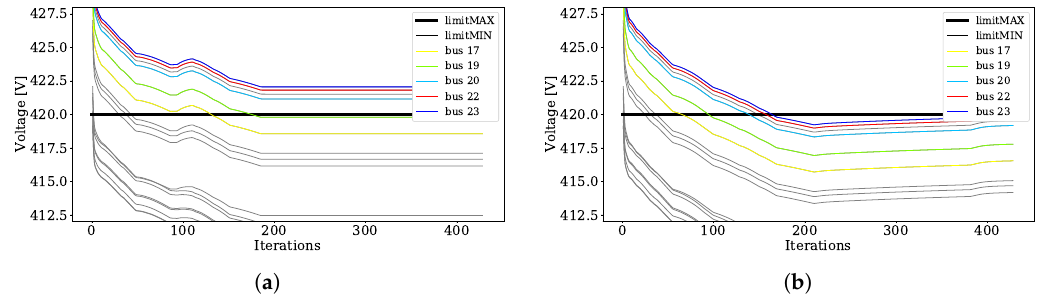
Figure 13. Voltage profile without virtual nodes and with virtual nodes. ( a ) Without virtual nodes ( b ) With virtual nodes.